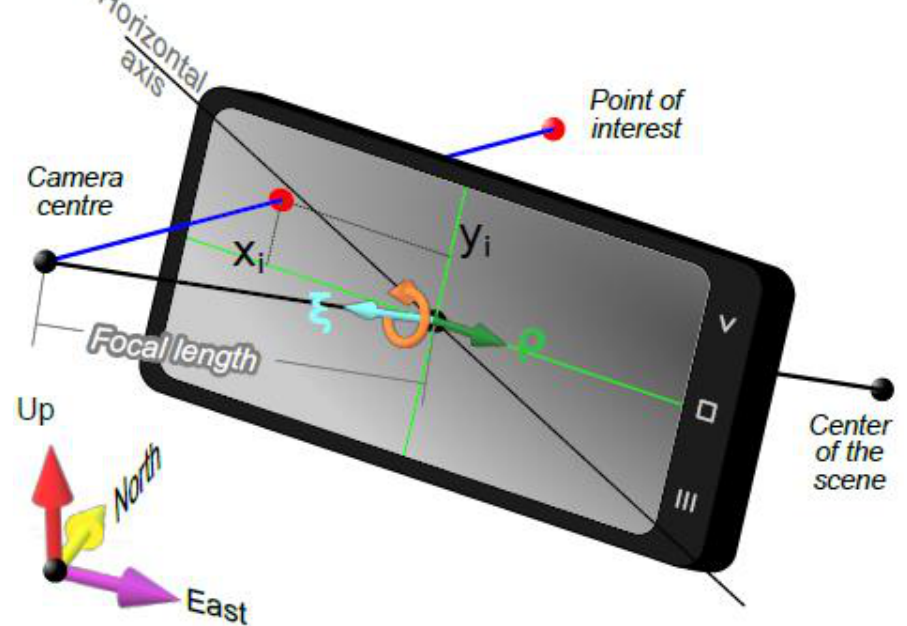
Figure 6. Pinhole camera model. The camera center and focal length are shown outside the phone for sake of simplicity. ξ is the unit vector defining the camera view direction; ρ is the unit vector orthogonal to the camera view direction and containing the image long axis. Table 1. Parameters and acronymous notation.